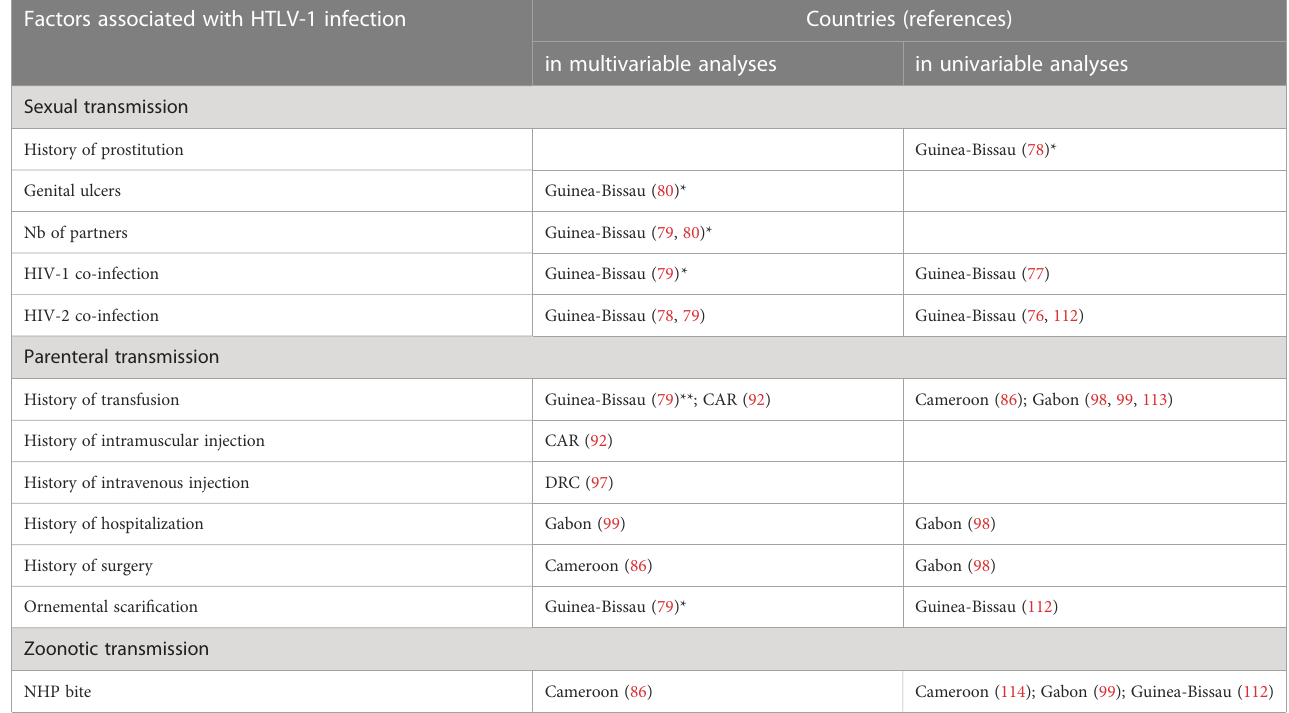
TABLE 4 Cross-sectional studies of HTLV-1 transmission risk and associated risk